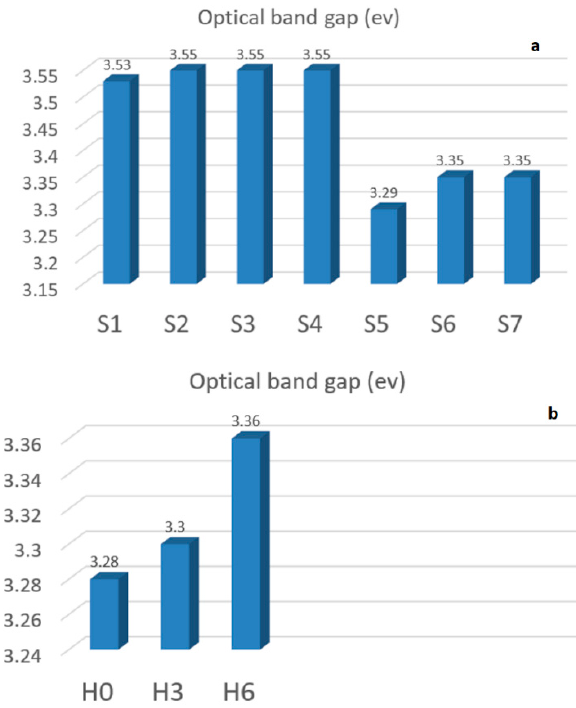
Figure 9. ( a ) The optical band gap of the deposited IZO films was calculated via a Tauc plot. The samples deposited by Ar + H gas demonstrate a wider optical band gap, while the samples coated under Ar gas have a slightly narrower bandgap. The transition sample S5, has the narrowest bandgap. ( b ) In ZnO samples, prolonged exposure to the ArH gas seems to slightly increase the optical bandgap of the material.